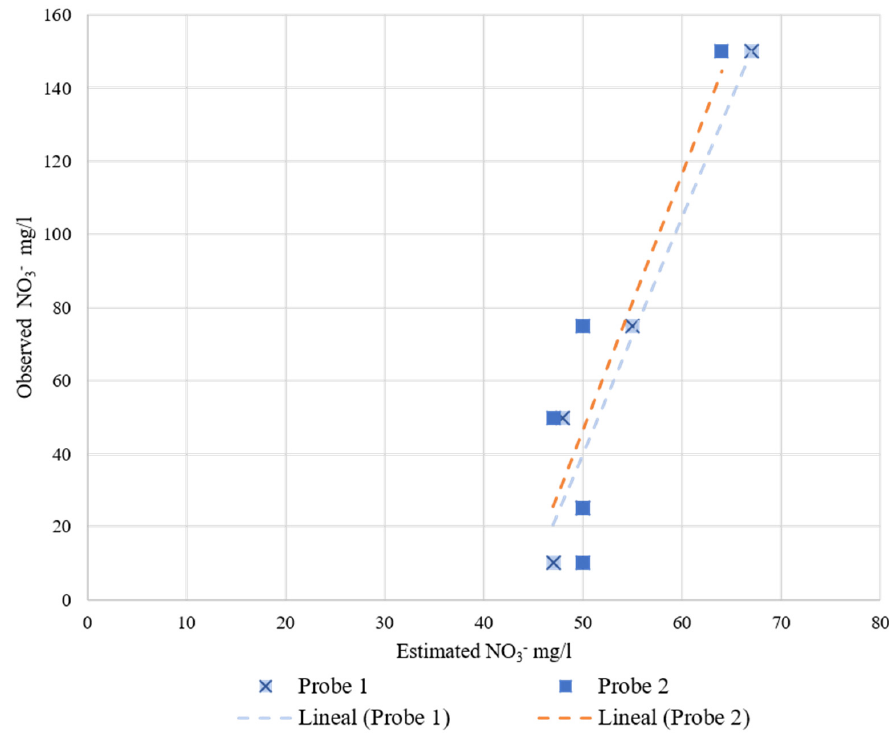
Figure 12. JXCT probes’ behavior at increasing nitrate concentration at a 35% volumetric soil moisture. On the x -axis is the estimated nitrate concentration measured by the probes and on the y -axis is the observed nitrate concentration. Table 7. Fitting and determination coefficient for the JXCT probes when increasing the nitrate con- centration in sand at 35% volumetric soil moisture.